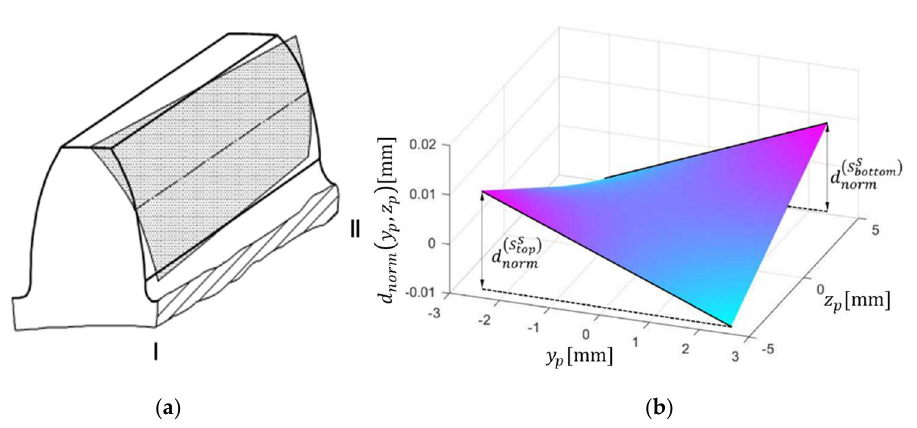
Figure 4. The tooth flank twist in the gear coordinate system and the meshing plane coordinate system. ( a ) Flank twist. ( b ) Flank twist in the meshing